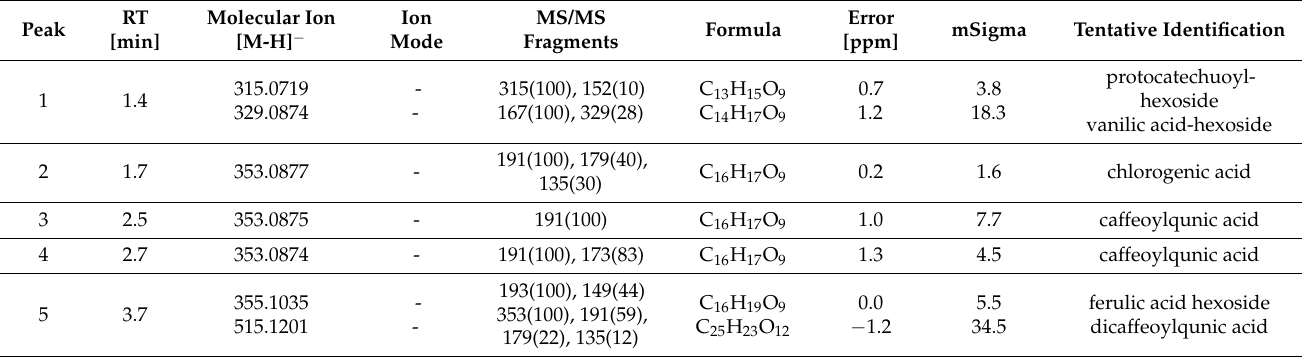
Table 5. Compounds identified in the chamomile ( Matricaria chamomilla L.) extract using UHPLC-QTOF-MS/MS. Compound numbers correspond to those indicated in Figure